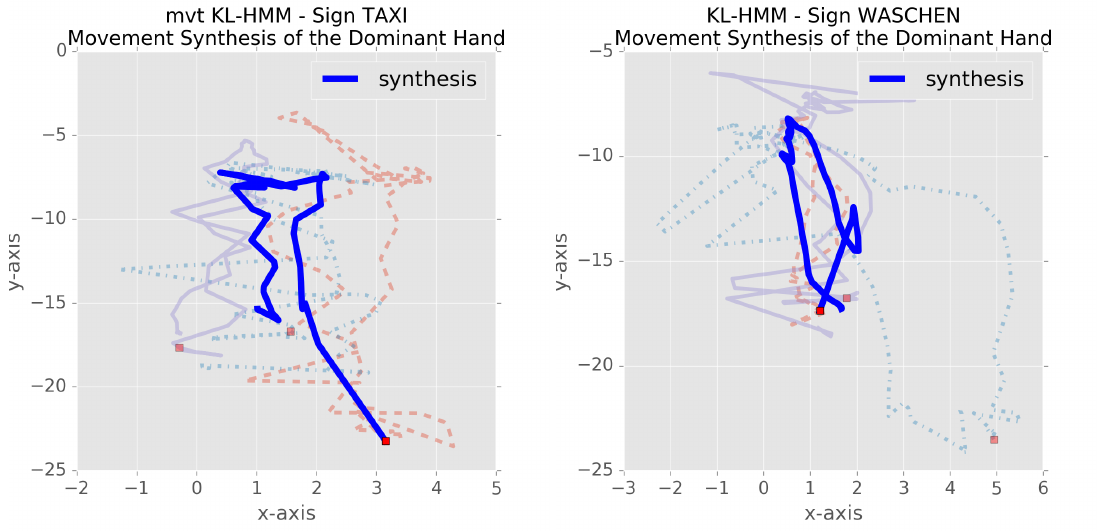
Figure 5. Movement synthesis of the dominant hand for the well-recognized sign, TAXI ( left ), and the poorly-recognized sign, WASCHEN ( right ), using the Gaussian distribution sequence computed from the subunit-based KL-HMM system, where the red square are the starting points.